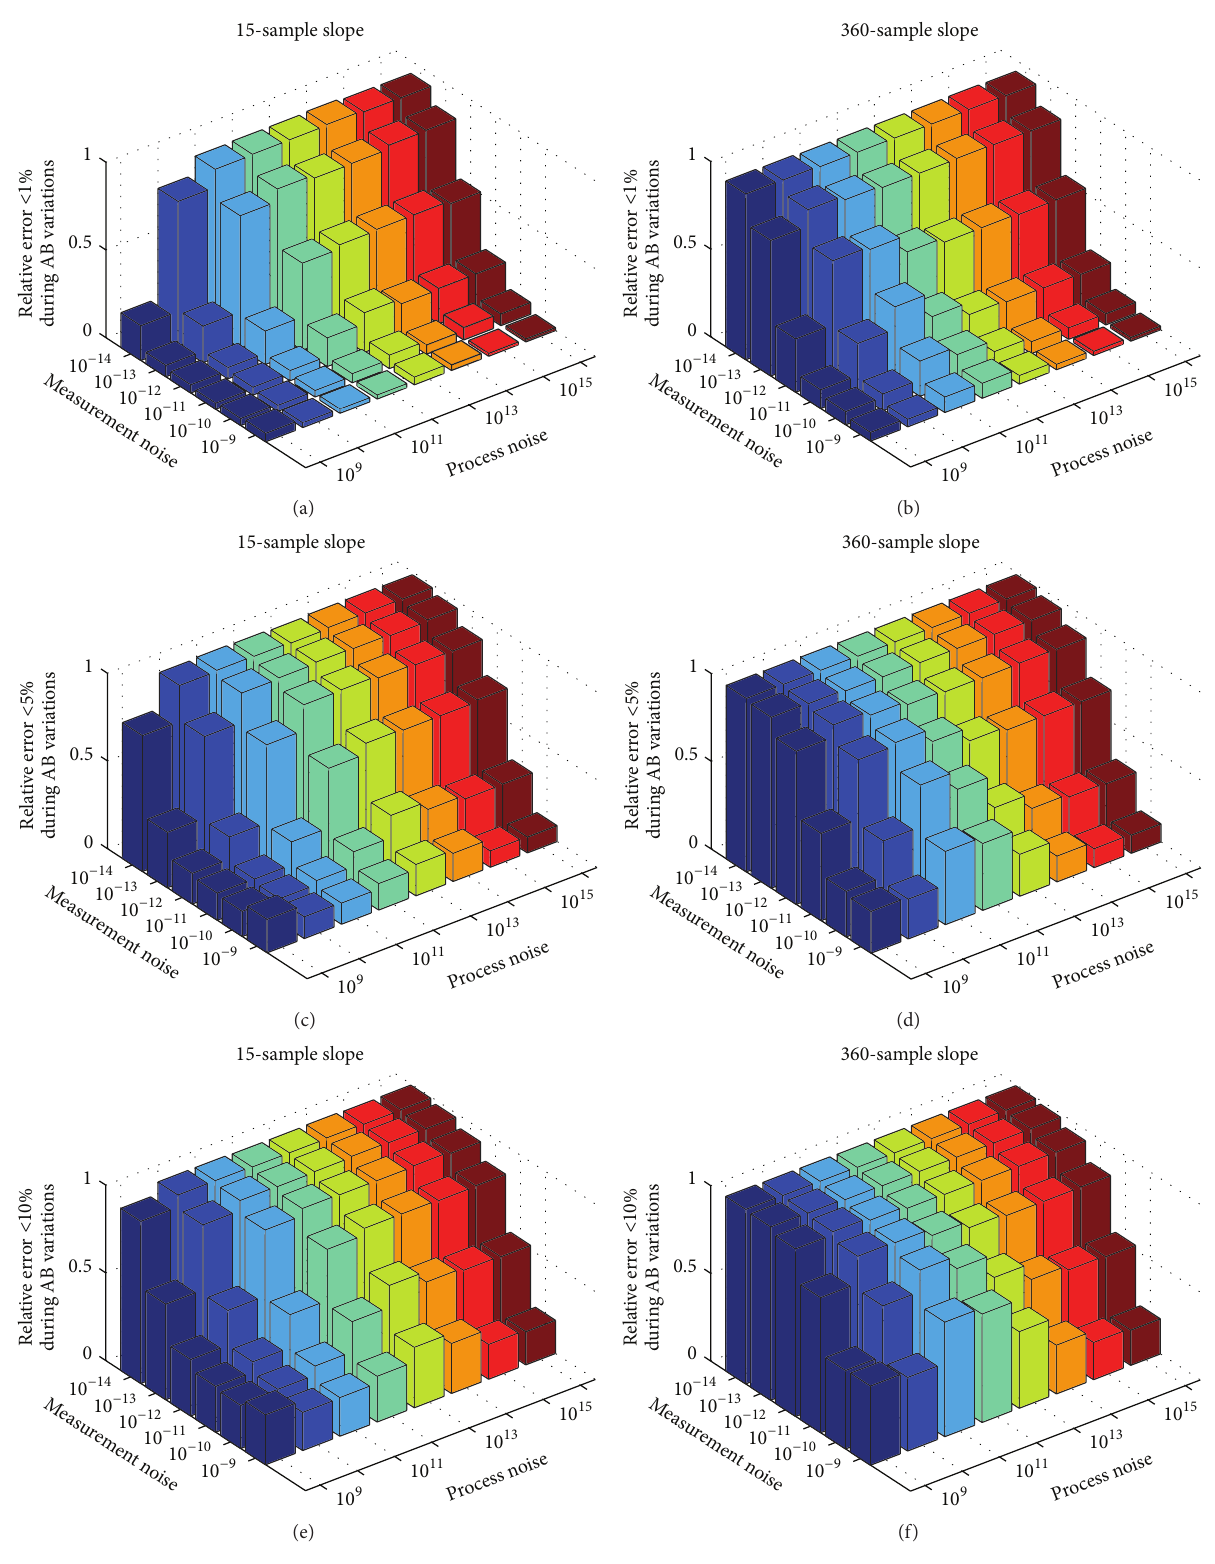
Figure 4: Percentage of relative errors that are below different thresholds 𝜃 for fast AB variations (a, c, and e) and slow AB variations (b, d, and f). 𝜃 = 1 % in (a) and (b), 𝜃 = 5 % in (c) and (d), and 𝜃 = 10 % in (e) and